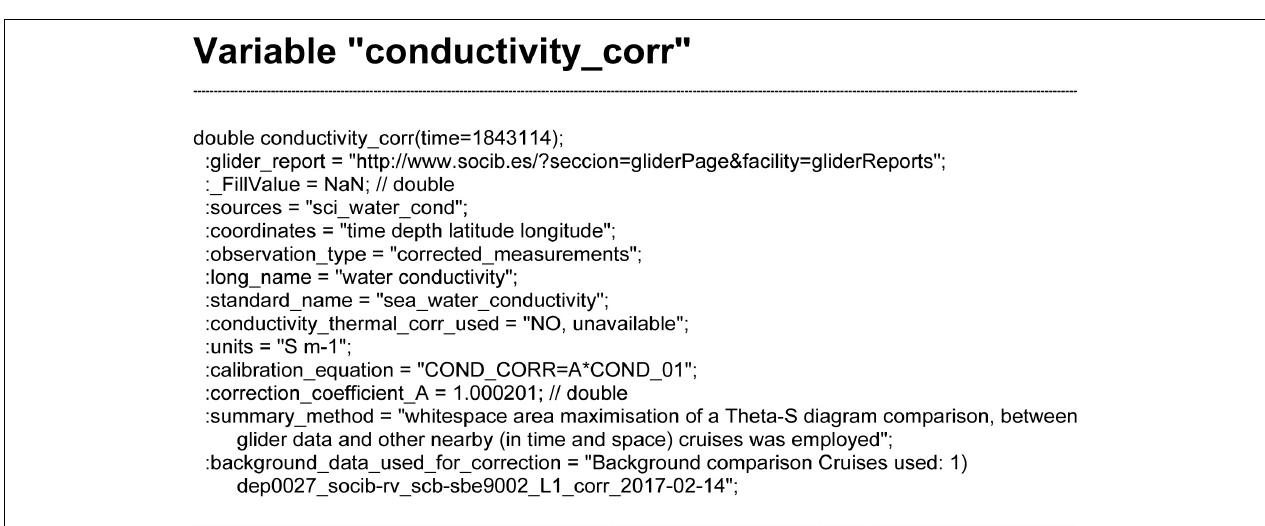
FIGURE 8 | Section of function imageArea_V2.m, indicating where, on line 58, the plotted dot size may be changed (markerSize = 10).